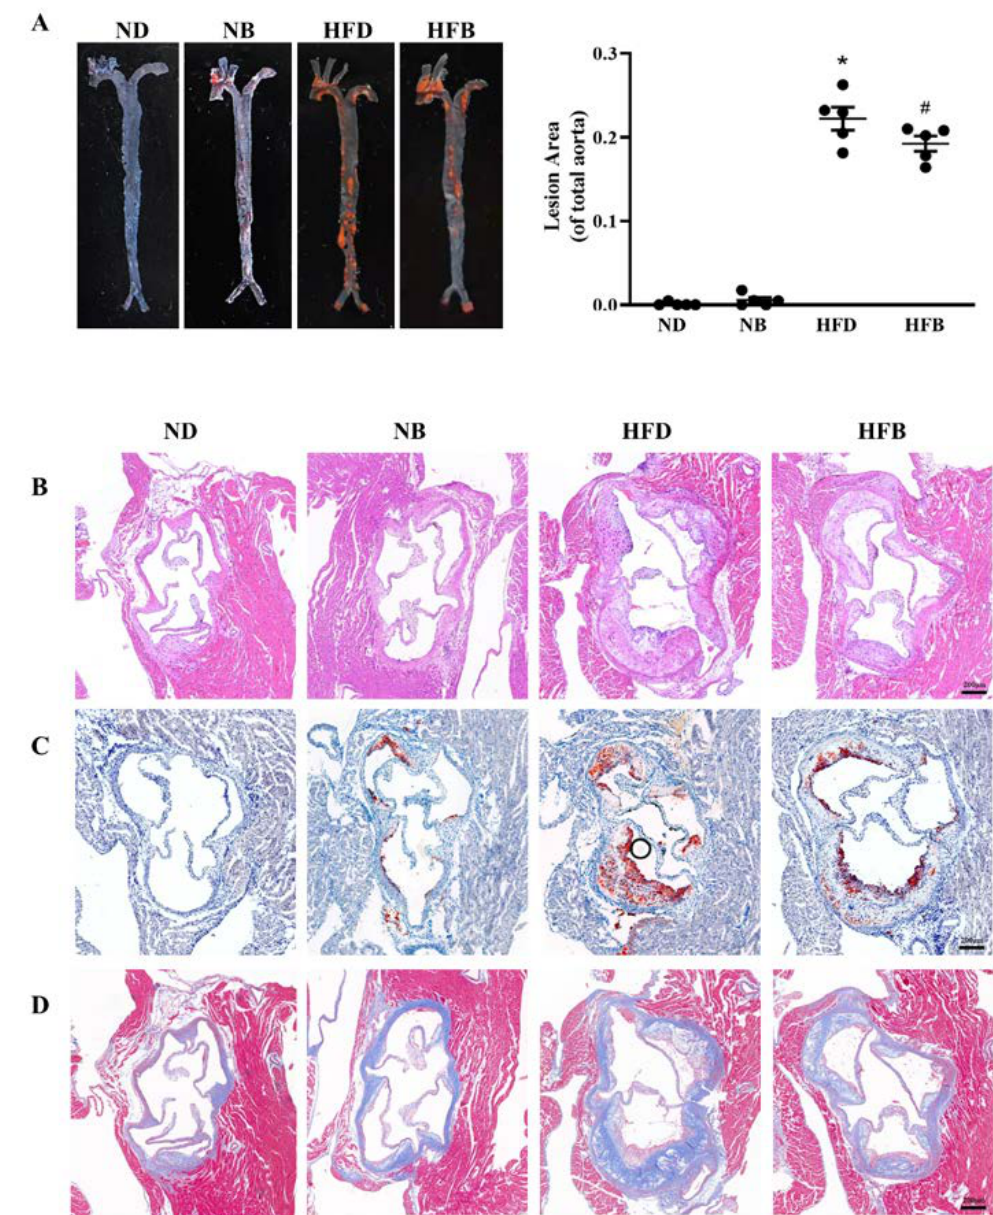
Figure 1. BCAA supplementation reduces atherosclerotic plaques induced by a high-fat diet in ApoE − / − mice. ( A ) Representative images of Oil Red O staining of the aorta (left) and lesion area (right). The lesion area was expressed as a percentage of the total aorta area ( n = 5 for each group). ( B – D ) Representative images of hematoxylin and eosin staining ( B ), Oil Red O staining ( C ), and Masson staining ( D ) of the aortic root (bar = 200 µ m). The data are expressed as the mean ± standard error of the mean (SEM). * p < 0.05 vs. ND group; # p < 0.05 vs. HFD group.